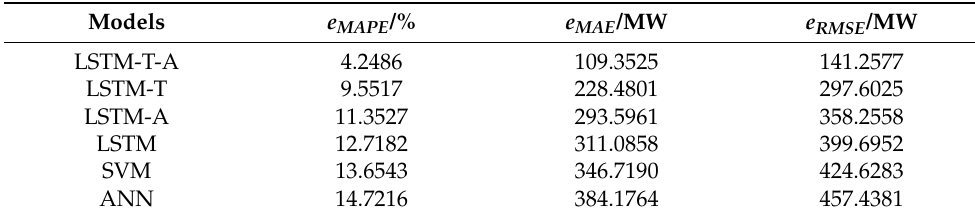
Table 4. Prediction performance comparison of different neural network